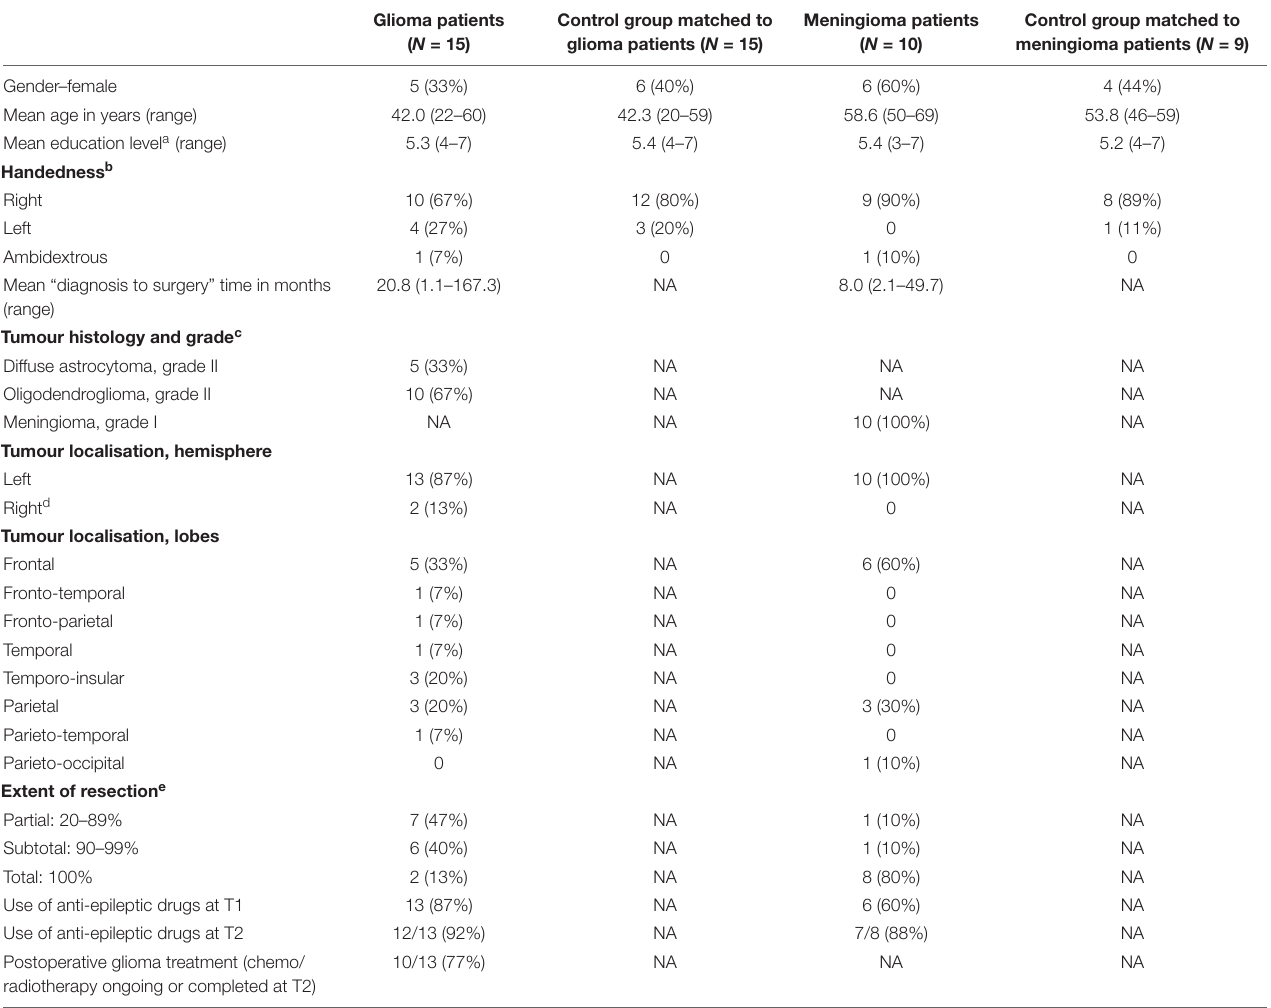
TABLE 3 | Demographic and clinical characteristics of the participants: number of participants (and percentage) or mean (and range).